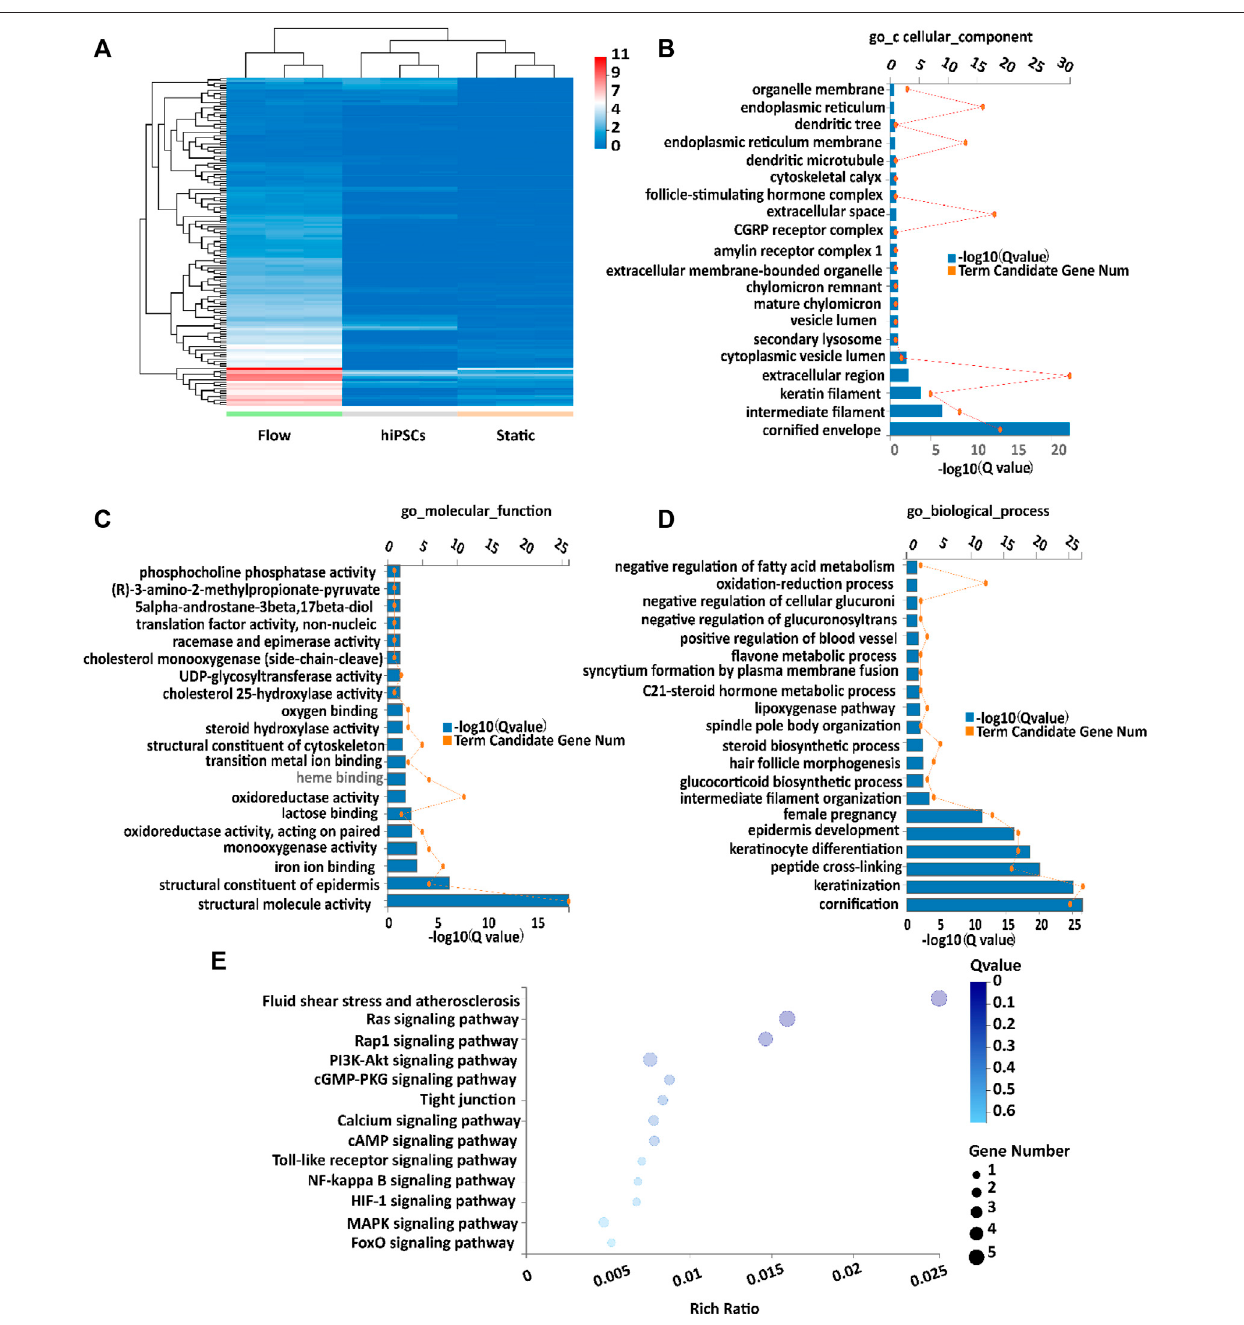
FIGURE 5 | Transcriptome analysis of placental trophoblast-like tissues under static and dynamic conditions. (A) Hierarchical clustering heatmap of upregulated DEGs in the fl ow group compared with the static group, the undifferentiated hiPSC group. (B – D) GO enrichment of upregulated DEGs according to the (B) cellular component, (C) molecular function, and (D) biological process. (E) KEGG analysis of upregulated DEGs in 3D tissues under dynamic conditions compared with static conditions.